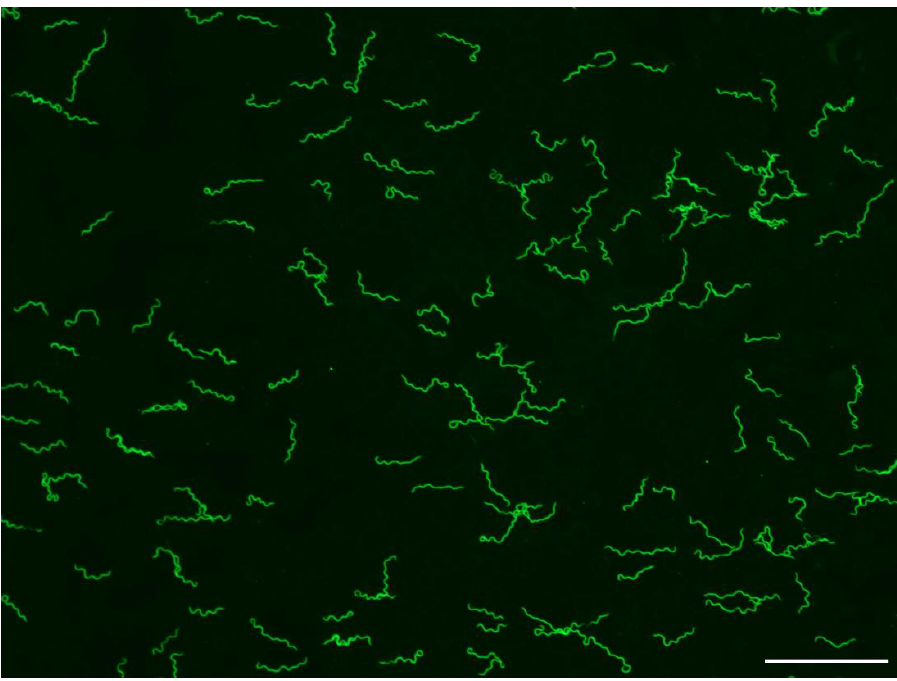
Figure 1. Borrelia hermsii MTW-4 in a thin, methanol-fixed mouse blood smear stained with anti- B. hermsii rabbit hyperimmune serum and goat anti-rabbit FITC. Scale bar = 40 µm.